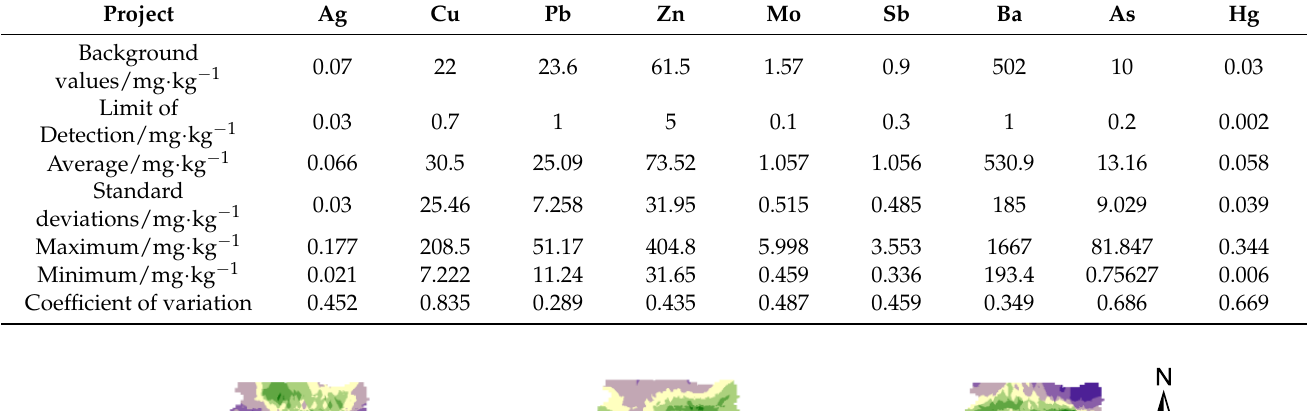
Table 2. Statistics of potentially toxic elements content in topsoil of the study area( n = 283).